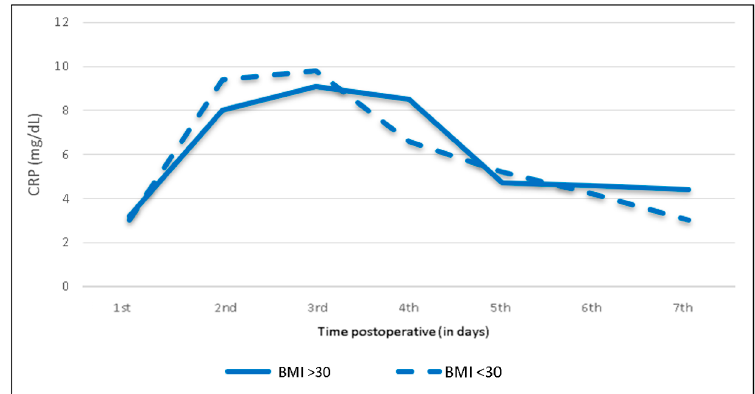
Figure 6. Body-mass-index-specific mean C-reactive protein levels and trends following shoulder arthroplasty. BMI: body mass index.